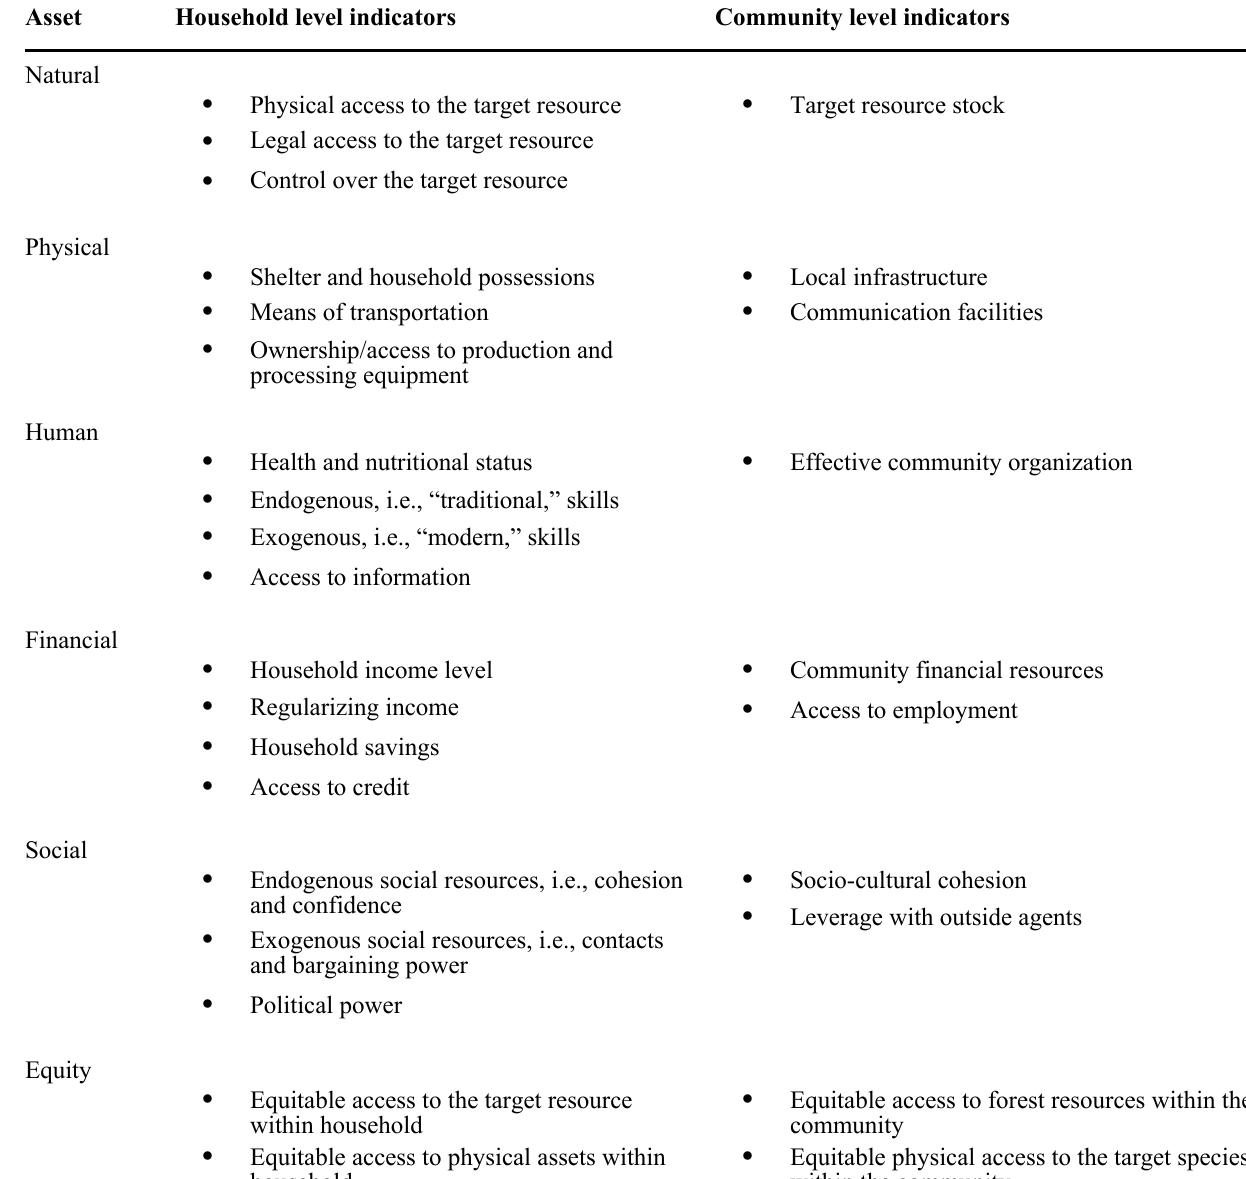
Table 1. Livelihood indicators at household and community levels.